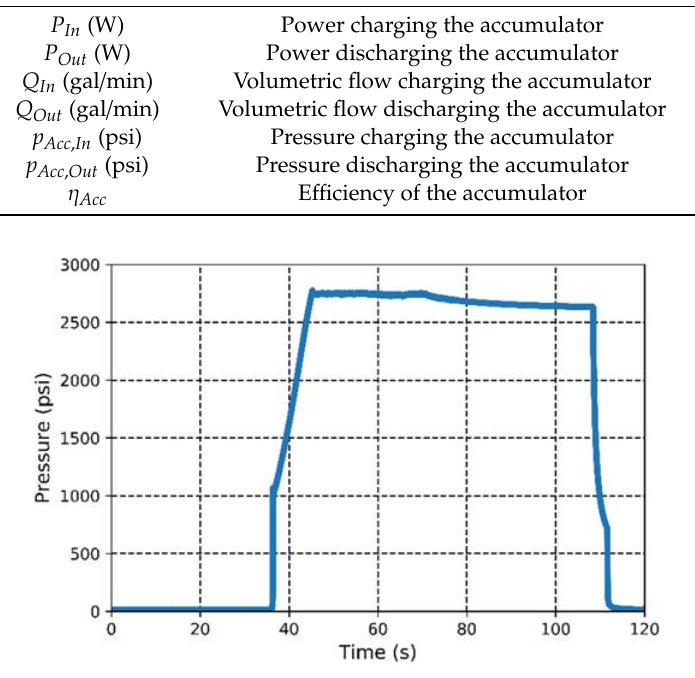
Figure 7. Pressure in the accumulator during the charging and discharging process.